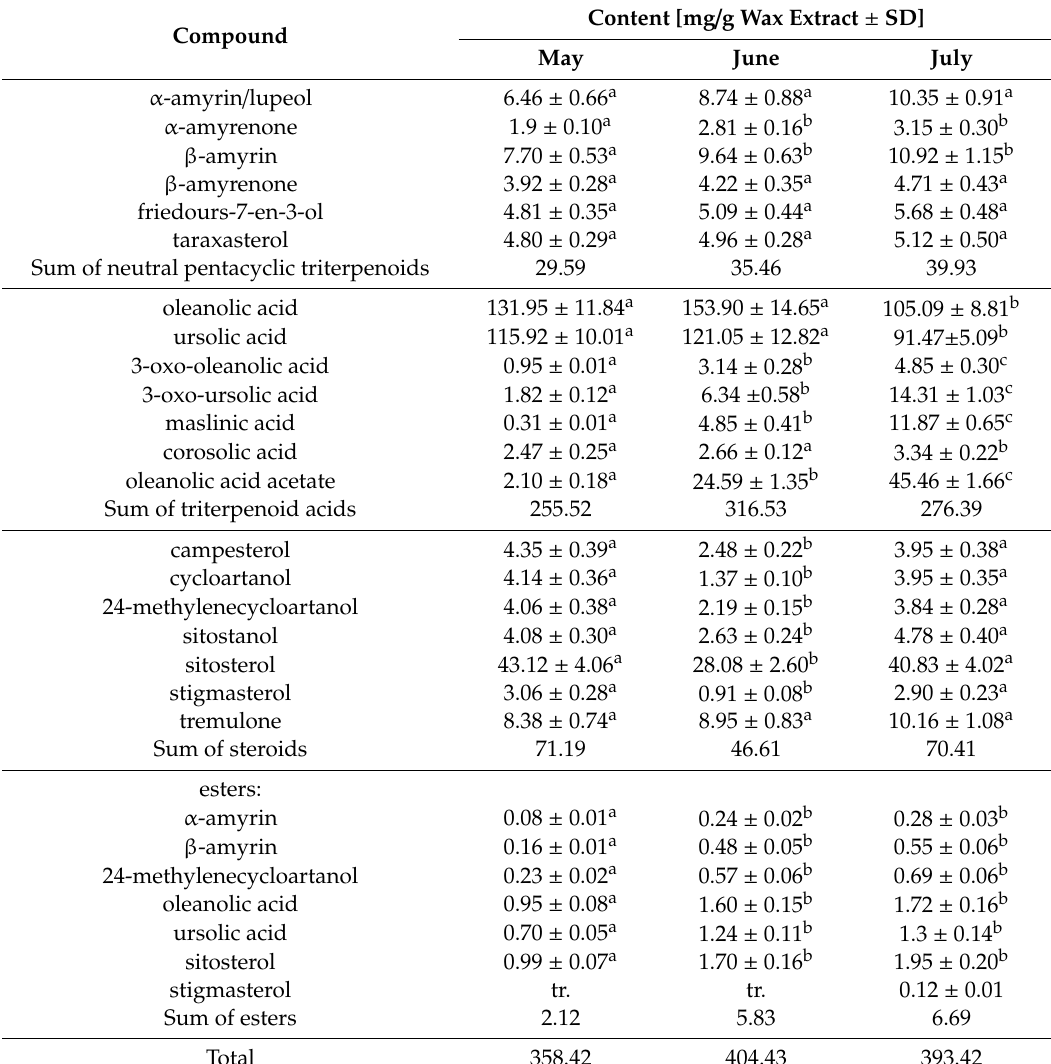
Table 2. Content of triterpenoids in cuticular waxes during bilberry Vaccinium myrtillus fruit